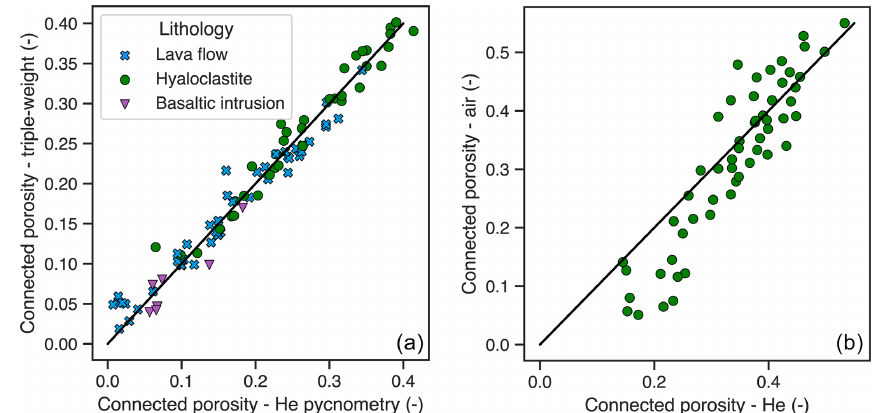
Figure 3. Comparison of connected porosity measurements using different measurement techniques. Panel (a) displays the connected poros- ity obtained by helium expansion versus the connected porosity measured using triple weighting; the data were derived from a subset of core samples originating from Krafla (Lévy et al., 2018, 2020b). Panel (b) presents a comparison of the connected porosity measurements on hyaloclastite tuffs using He or air as the saturating gas; the data are from Franzson et al. (2011).